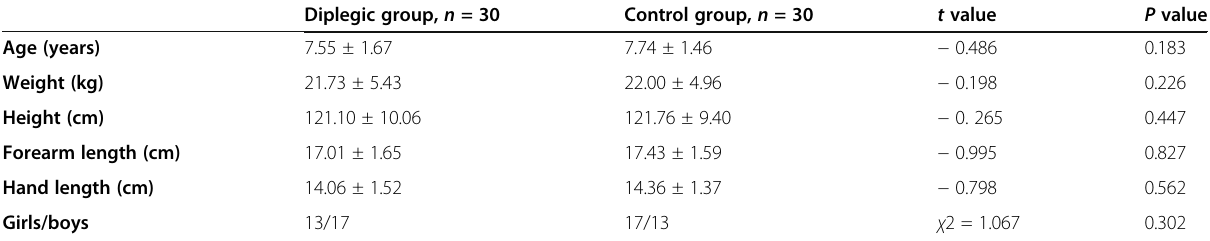
Table 1 Participants ’ baseline characteristics